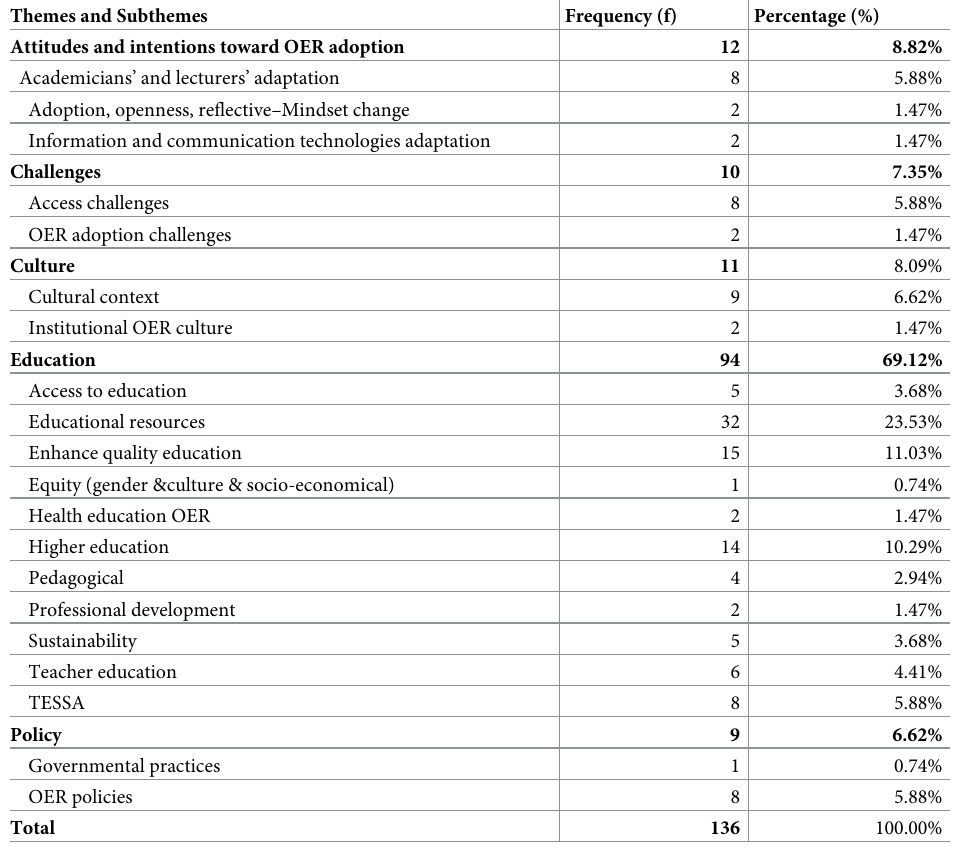
Table 4. Summary of the OER research focus in